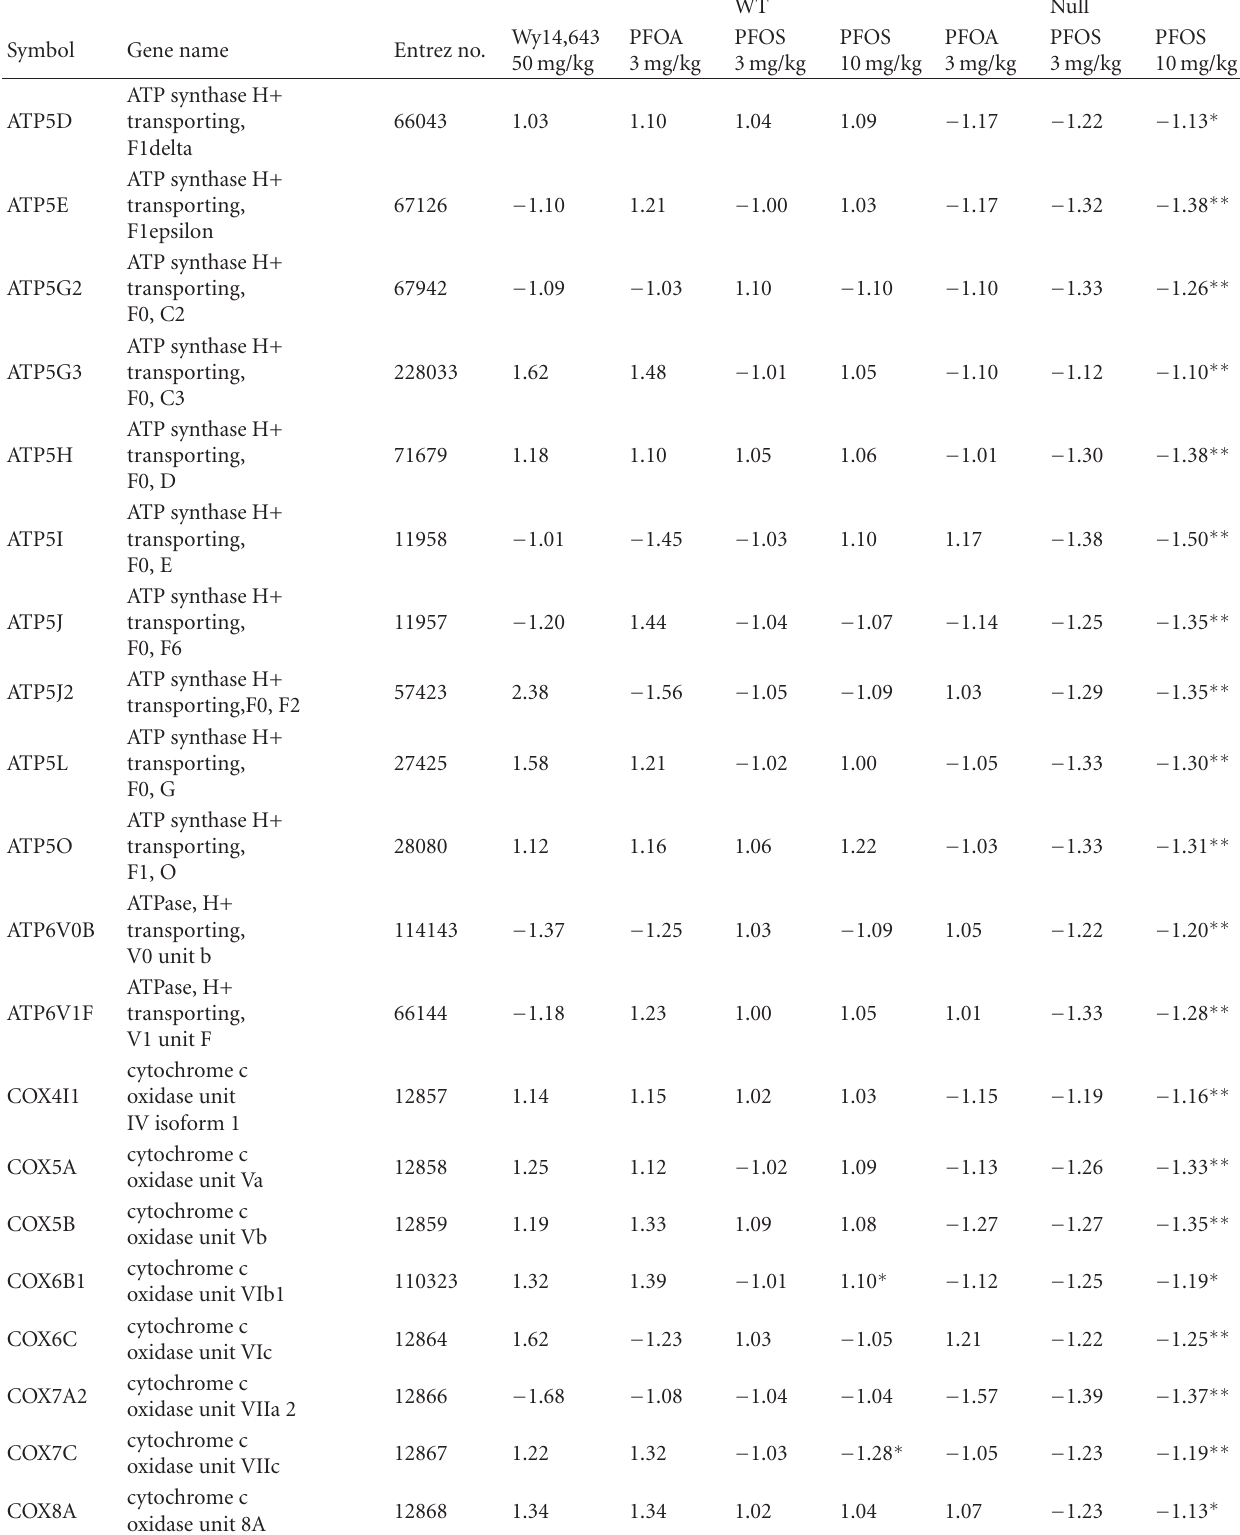
Table 9: Average fold change for genes related to oxidative phosphorylation/electron transport in wild-type and PPAR α -null male mice following a seven-day exposure to Wy-14,643 1 , PFOA 1 , or